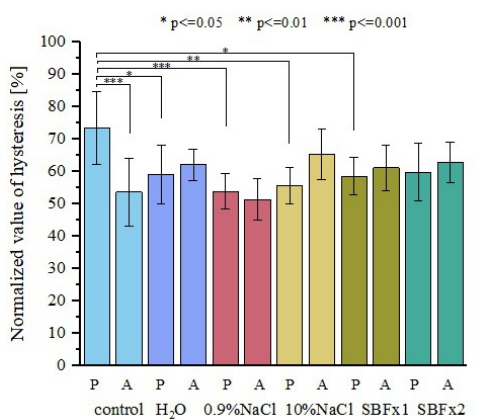
Figure 10. Normalized values of energy dissipation for anterior and posterior side of the tendon; p < 0.05; n =